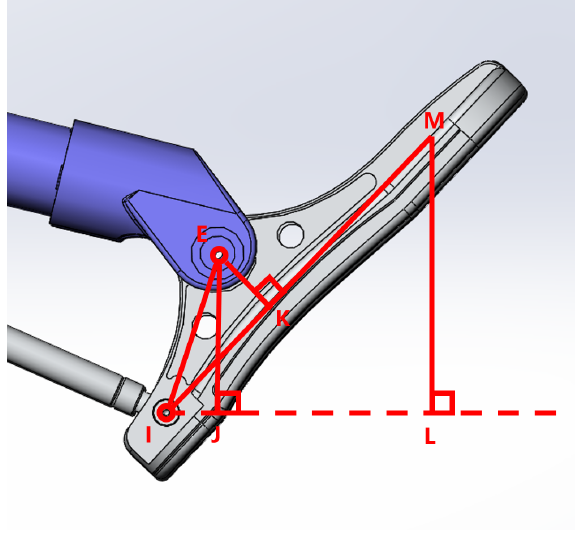
Figure 3. Foot end